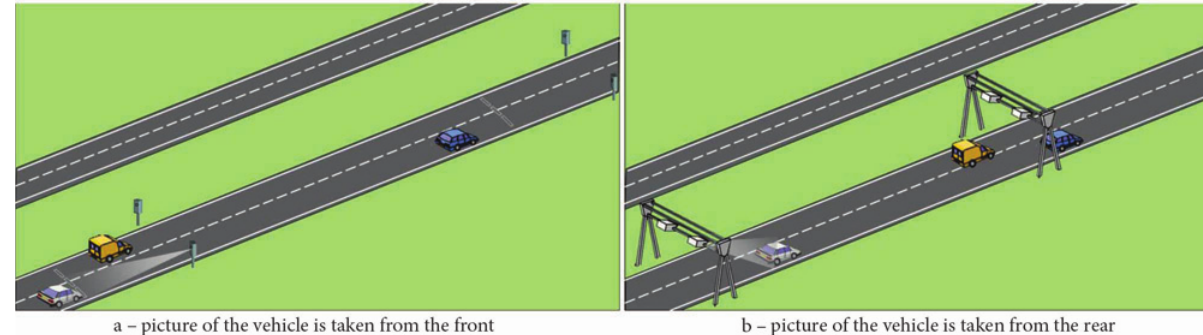
Fig. 1. Basic diagram of an average speed enforcement